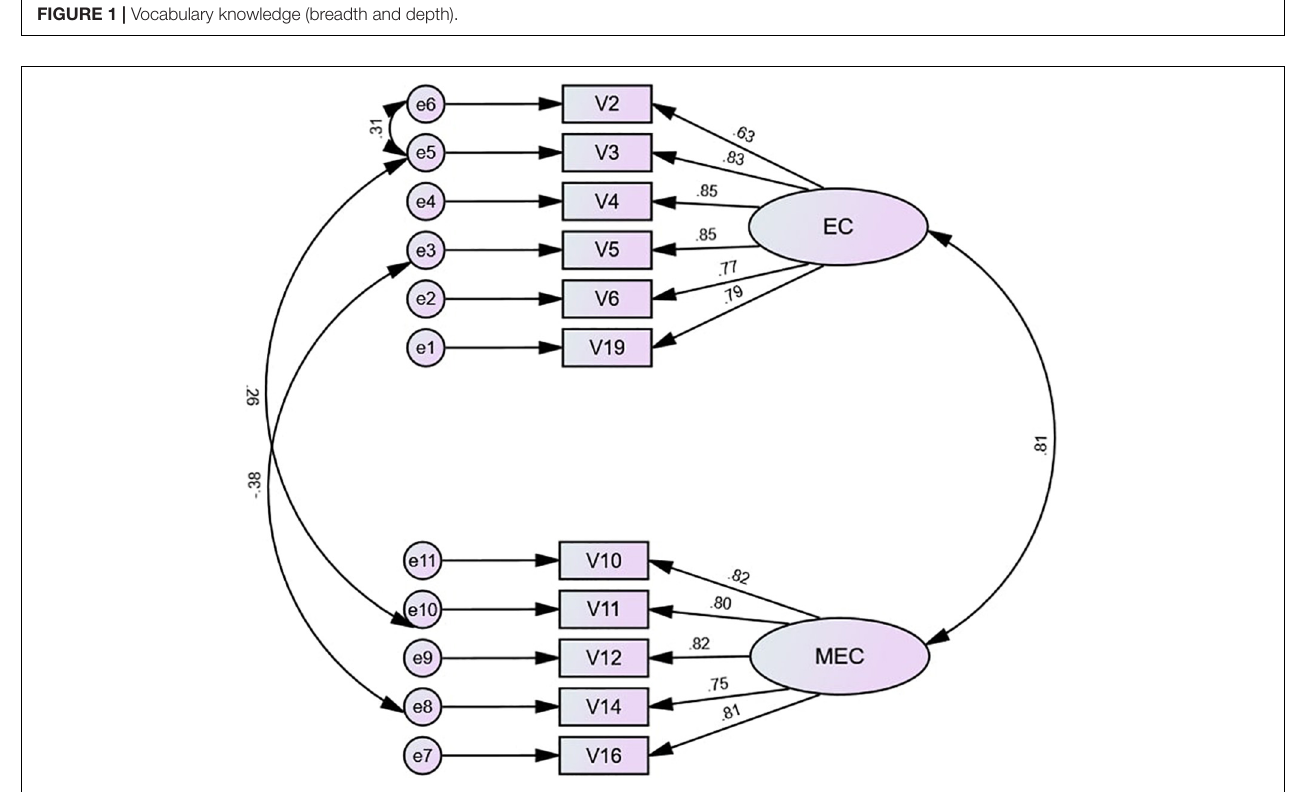
FIGURE 2 | The structural equation model of self-regulation. EC, emotion control items, MEC, metacognitive control